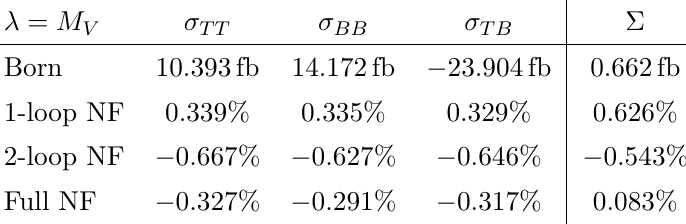
Table 1. Replaces table 1.